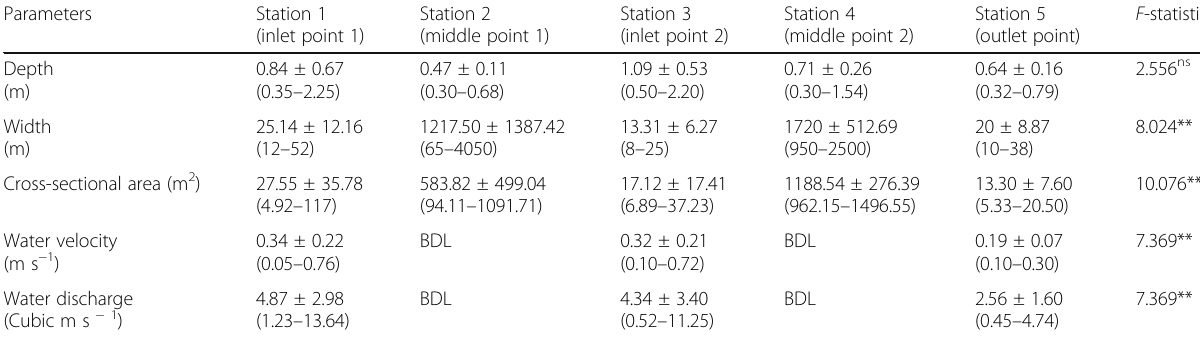
Table 4 Micro-topography and flow parameters in the wetland in different sampling stations; and, one-way analyses of variance showing variations in micro-topography and flow parameters in the wetland with sampling stations as the main effect variable